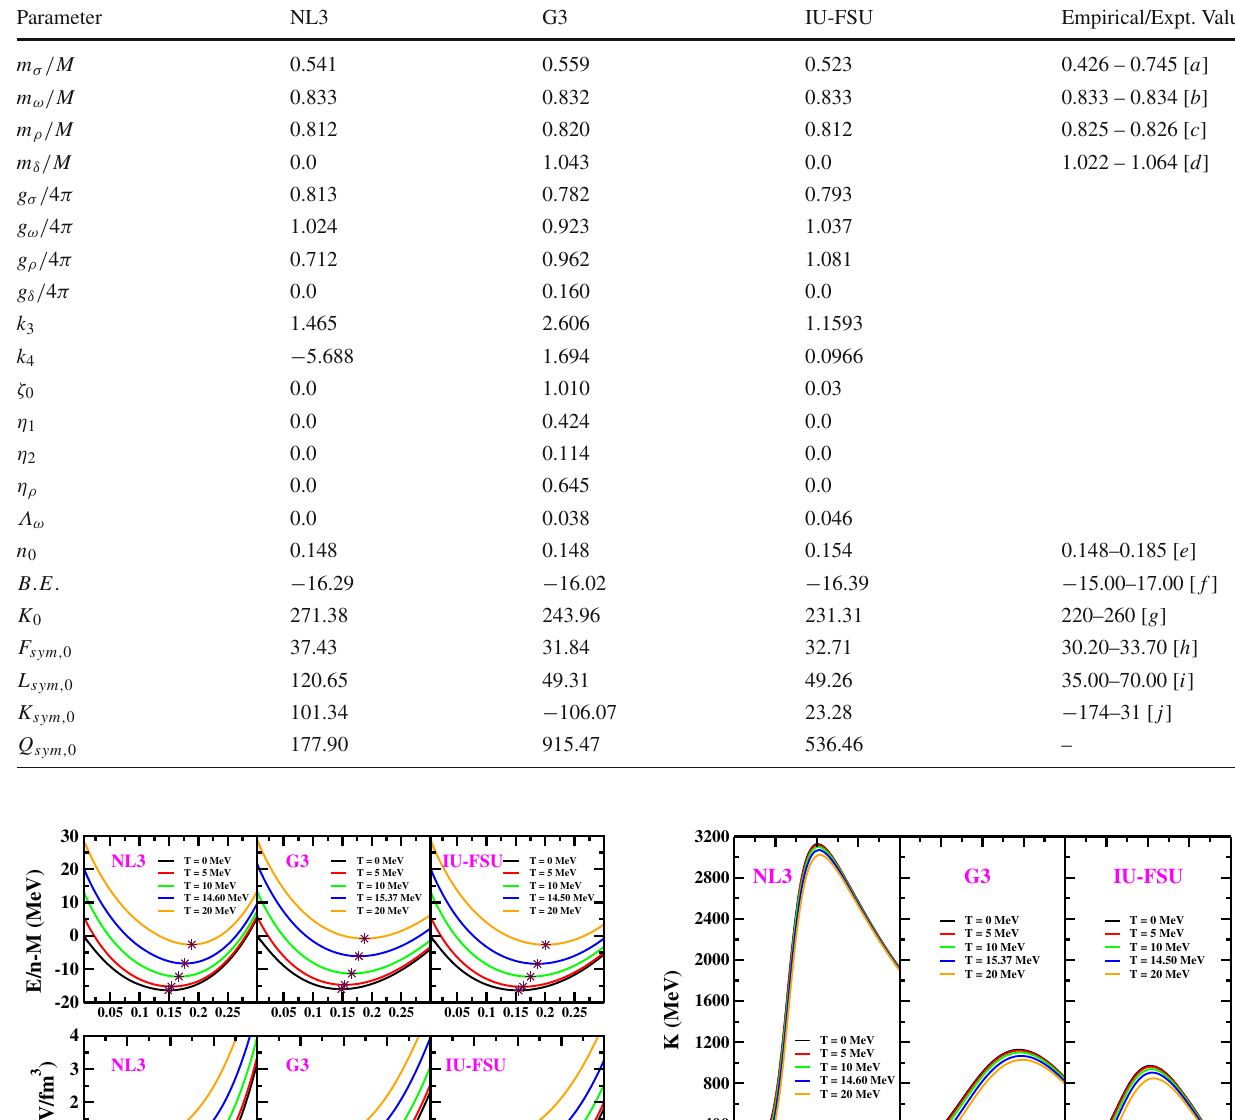
Table 1 The coupling constants and the NM properties at saturation for cold EoS of NL3 [43], G3 [44] and IU-FSU [42] parameter sets. The nucleon mass ( M ) is 939.0 MeV. All of the coupling parameters are dimensionless and the NM parameters are in MeV, except k 3 and n 0